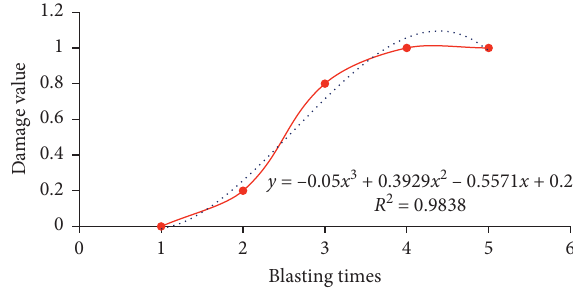
Figure 18: The regression relationship between the blasting damage value of R 1 and blasting times. Table 3: The relationship between the damage value of some unit monitoring points of the rock anchor beam along the axis of the powerhouse and blasting times. Regression analysis Monitoring points Confidence level Relationship between damage value ( y ) and blasting times ( x